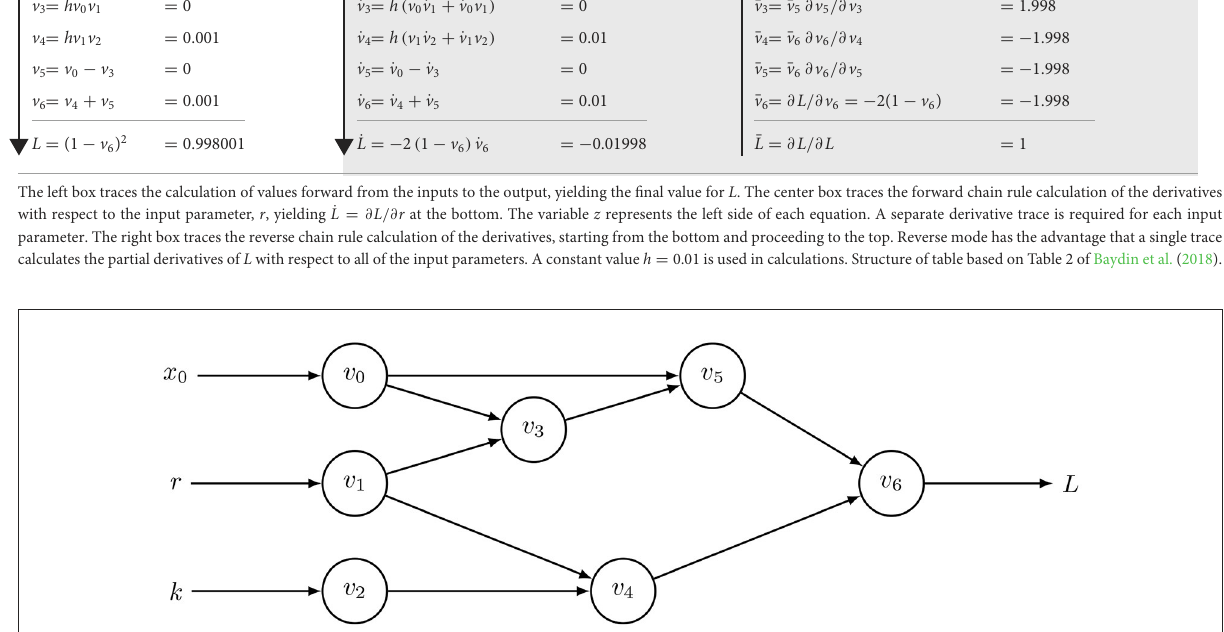
FIGURE1 Computational graph to calculate L ( x h ) = (1 − x h ) 2 for Equation (2) with t = 0 and h = 0.01, in which optimization seeks to minimize the loss function, L . Table 1 shows the intermediate results, v i , with v 6 = x h . This computational graph can be recursively expanded n times by using v 6 = x t as the starting point for additional applications of Equation (2) to calculate x nh for any integer, n . The resulting graph quickly becomes too large to visualize or to trace the pathways of calculation without some automatic method. However, computer code readily expands such graphs and